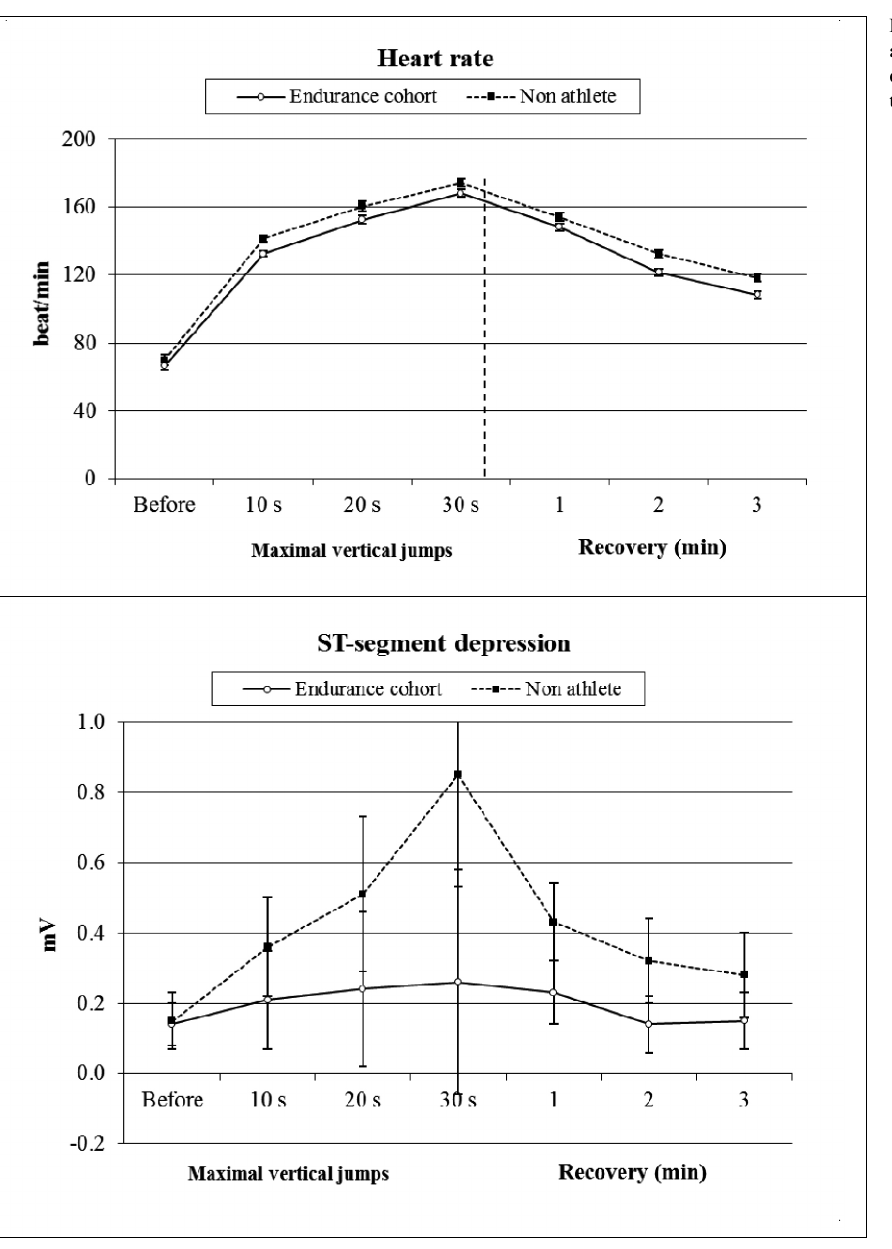
Figure 2. Dynamics of HR (A) and ST-segment depression during the 30-s vertical jumps test and